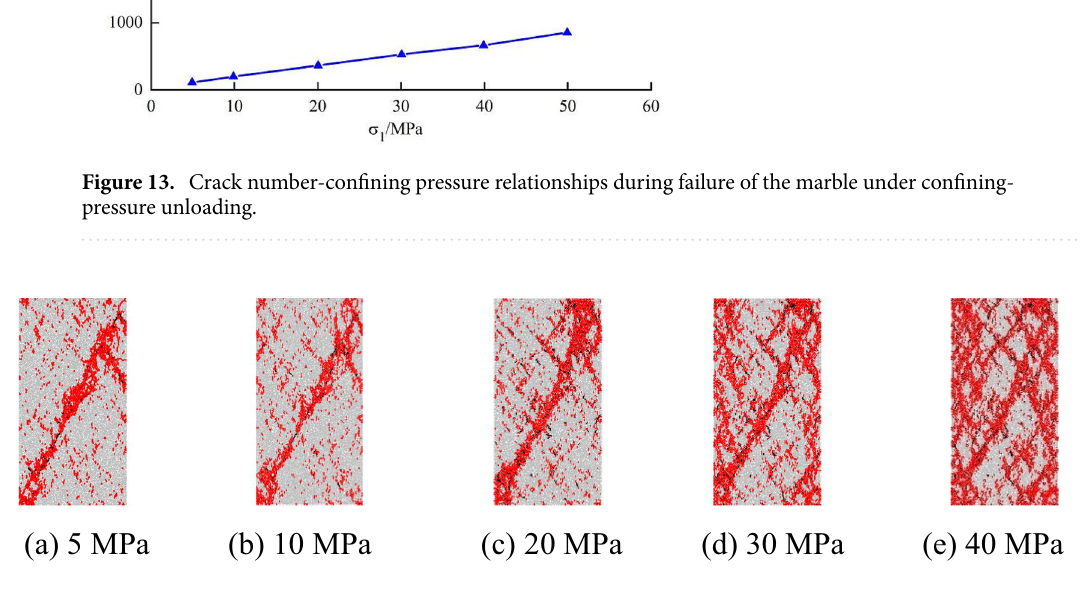
Figure 14. Mesoscopic failure modes of the marble under different confining